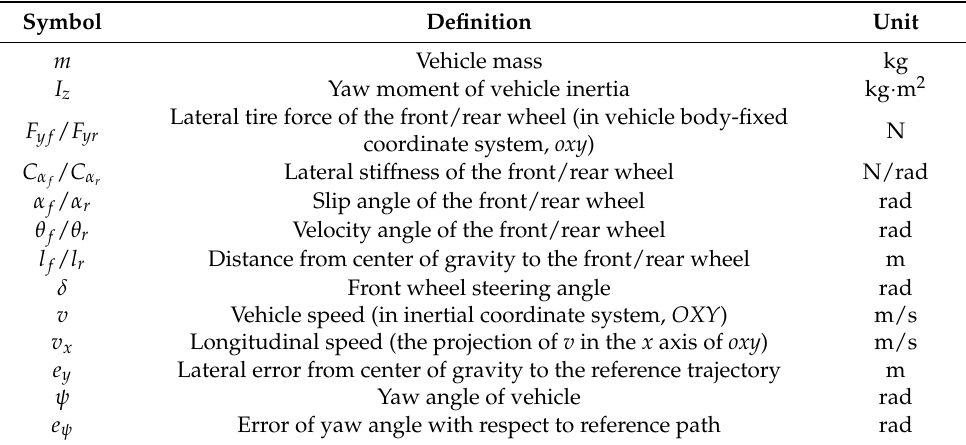
Figure 1. Vehicle dynamics model with a reference path. Table 1. Model